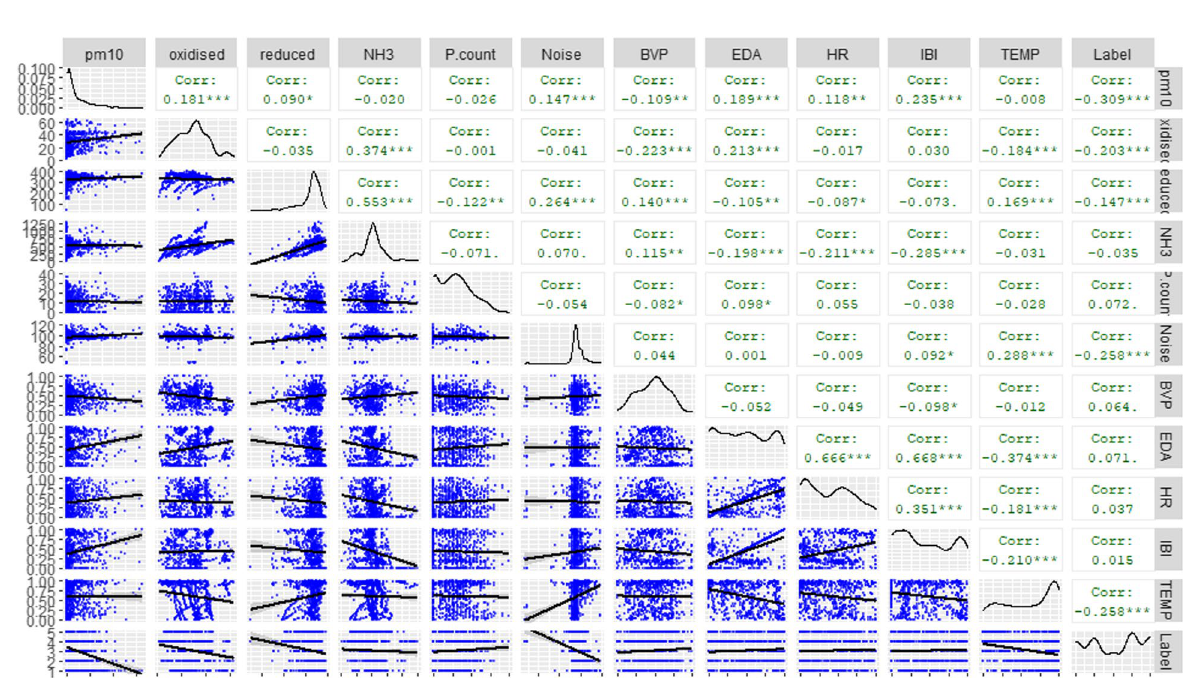
Fig. 6 Correlation Matrix of the Environmental and Physiological